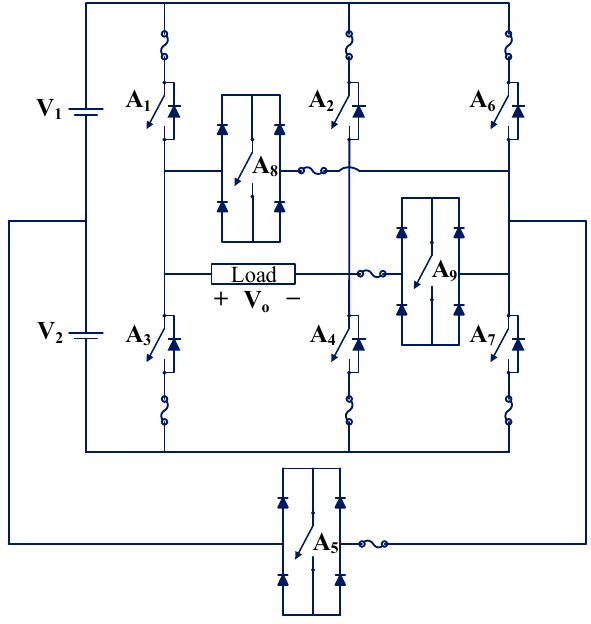
Figure 18. Single-phase five-level FT MLI (TP19) [54].